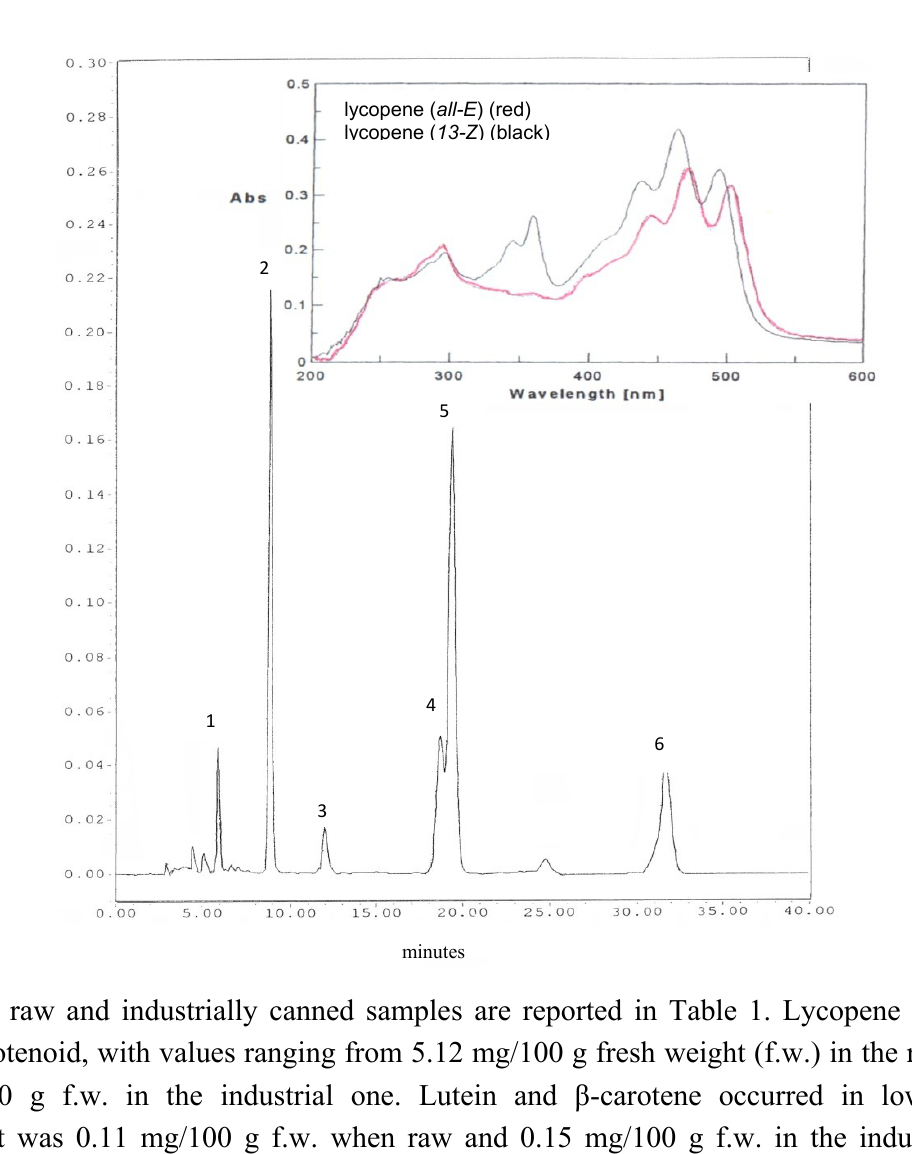
Figure 1. Carotenoid chromatographic separation in raw cherry tomato. Peaks: 1, lutein; 2, β-apo-8′-carotenal (ISTD); 3, unidentified peak (supposed lycopene Z isomer); 4, lycopene 13- Z ; 5, lycopene all E ; 6, β-carotene.